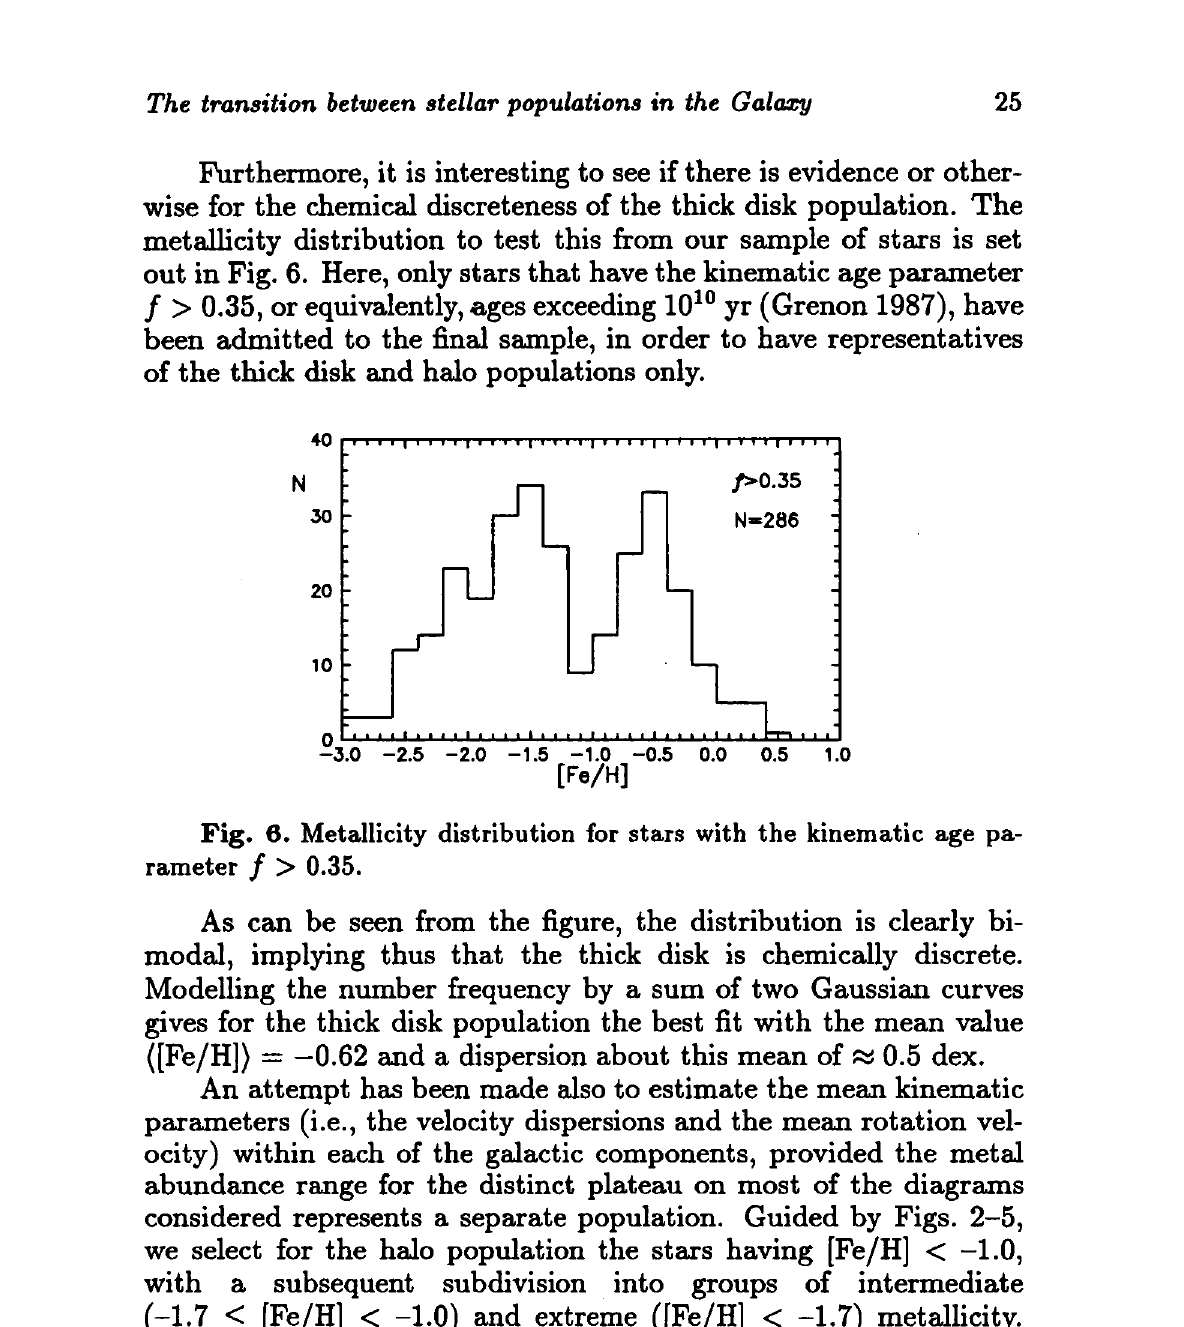
Fig. β. Metallicity distribution for stars with the kinematic age pa- rameter / >